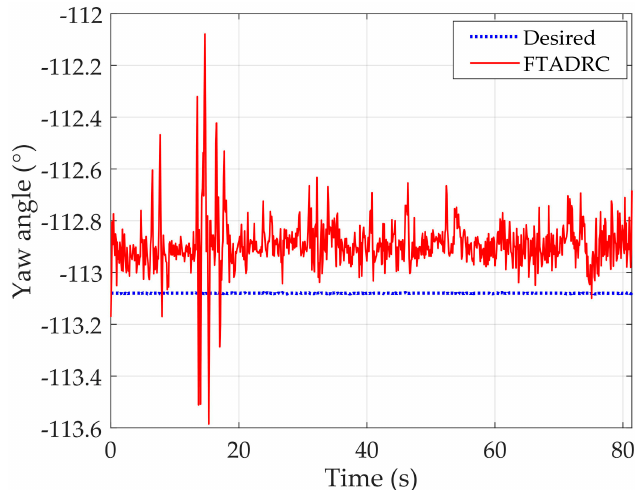
Figure 22. Curves of yaw angle. Electronics 2018 , 7 , x FOR PEER REVIEW